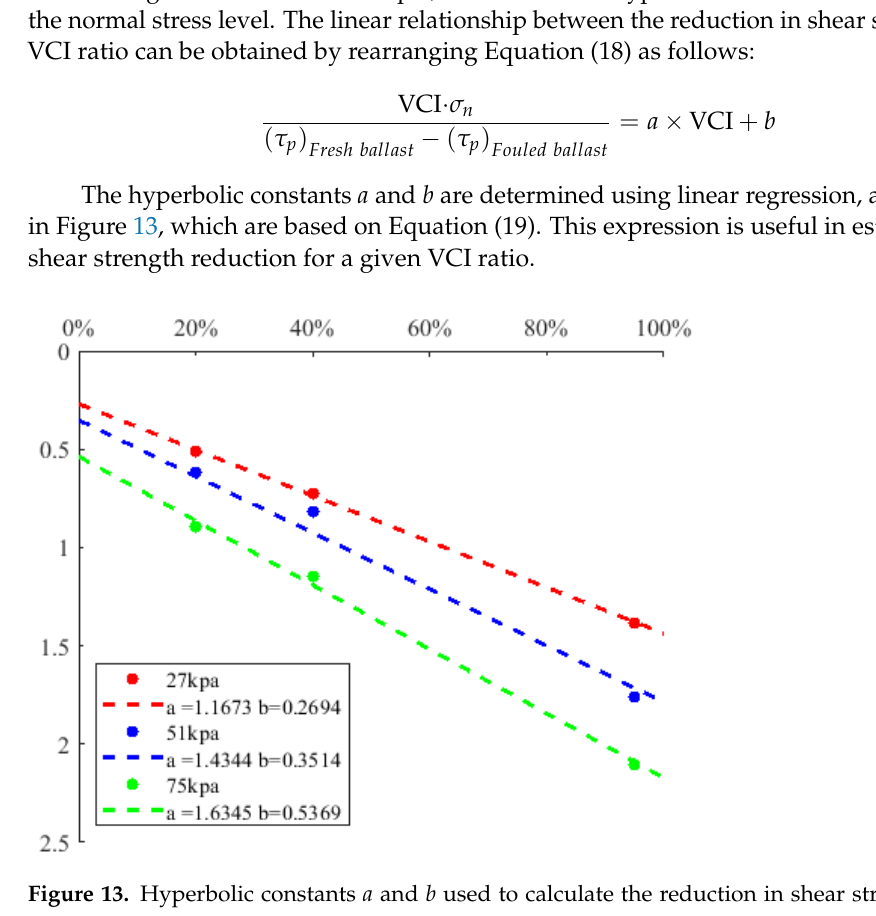
Figure 13. Hyperbolic constants a and b used to calculate the reduction in shear strength due to particle VCI.